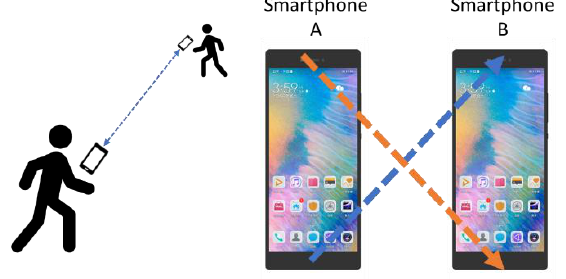
Figure 1. The structure of BeepBeep.